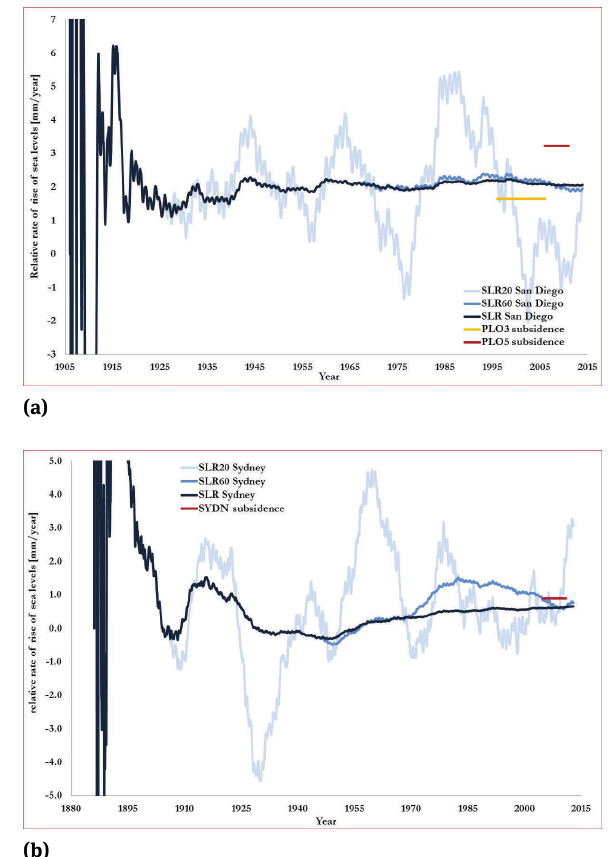
Fig. 1: Classical determination of the relative rate of rise by linear fitting in two tide gauges of the Pacific, Sydney and San Diego, with multi-decadal oscillations not phased and different subsidence and length. In one tide gauge, the rate of rise is marginally rising and in the other the rate of rise is marginally reducing. The short term tide window is misleading in both locations, showing relative rates of rise much larger or smaller than the true values. The vertical ve- locity of the SONEL GPS dome nearby the Sydney tide gauge (SYDN) is − 0.89 mm/year while the vertical velocities of the two SONEL GPS dome nearby the San Diego tide gauge (PLO3 & PLO5) are − 1.65 & − 3.23 mm/year. In both cases the subsidence accounts for the most part of the relative sea level rise. In both cases – as in every other long term tide gauge of the world – the first sign of sharply accelerating sea levels is still